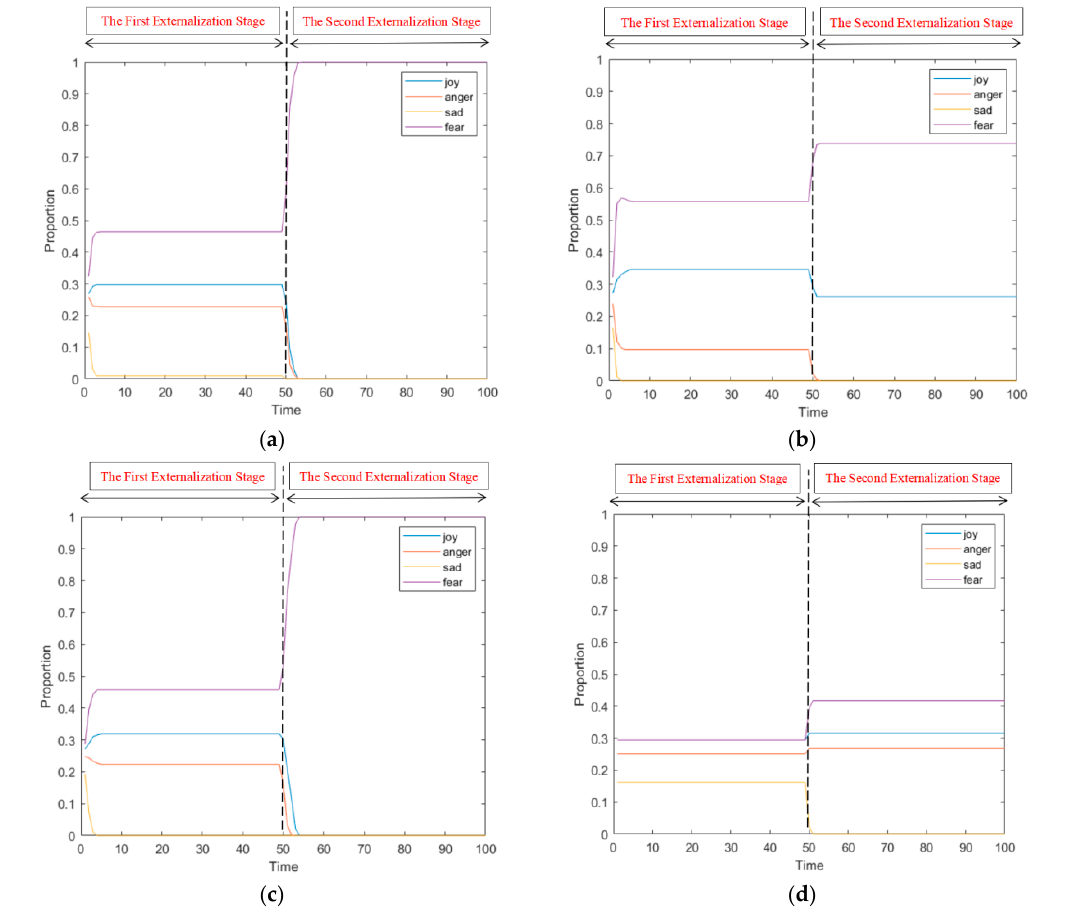
Figure 16. The change curve of the proportion of all kinds of attitudes in the two-stage interaction process with the number of interactions. ( a ) The change curve of the proportion of all kinds of attitudes in the two-stage interaction process with the number of interactions under BA network. ( b ) The change curve of the proportion of all kinds of attitudes in the two-stage interaction process with the number of interactions under WS small-world network. ( c ) The change curve of the proportion of all kinds of attitudes in the two-stage interaction process with the number of interactions under ER random network. ( d ) The change curve of the proportion of all kinds of attitudes in the two-stage interaction process with the number of interactions under Fully connected